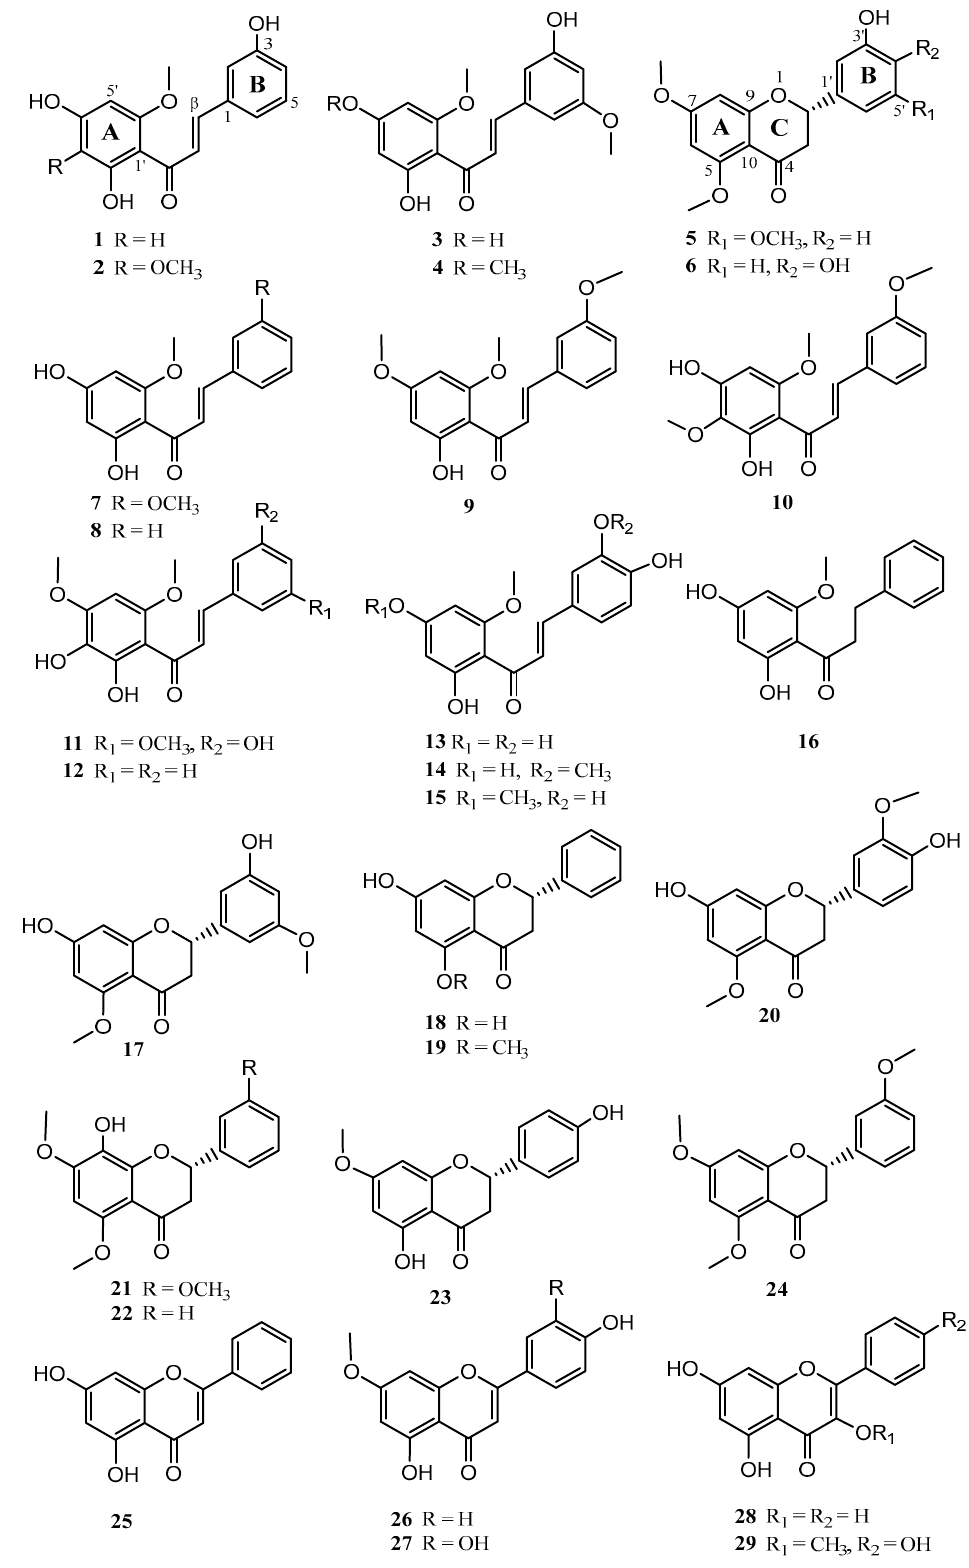
Figure 1. Chemical structure of flavonoids isolated from P. delineatum , P. divaricatum , and P. glabratum .